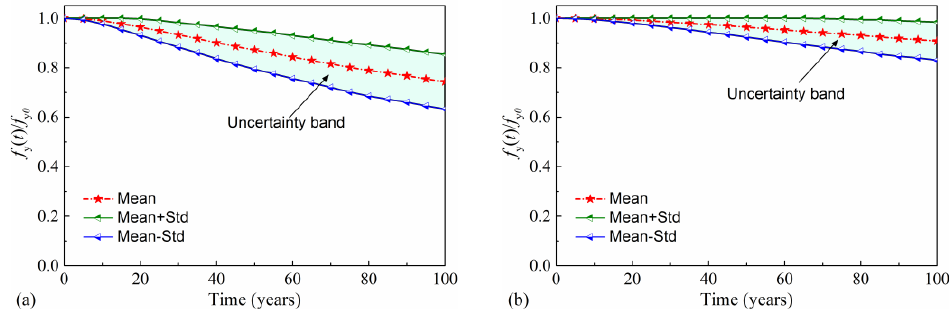
Figure 8. Time-variant NCSA of reinforcement: ( a ) splash and tidal zone; ( b ) atmospheric zone.